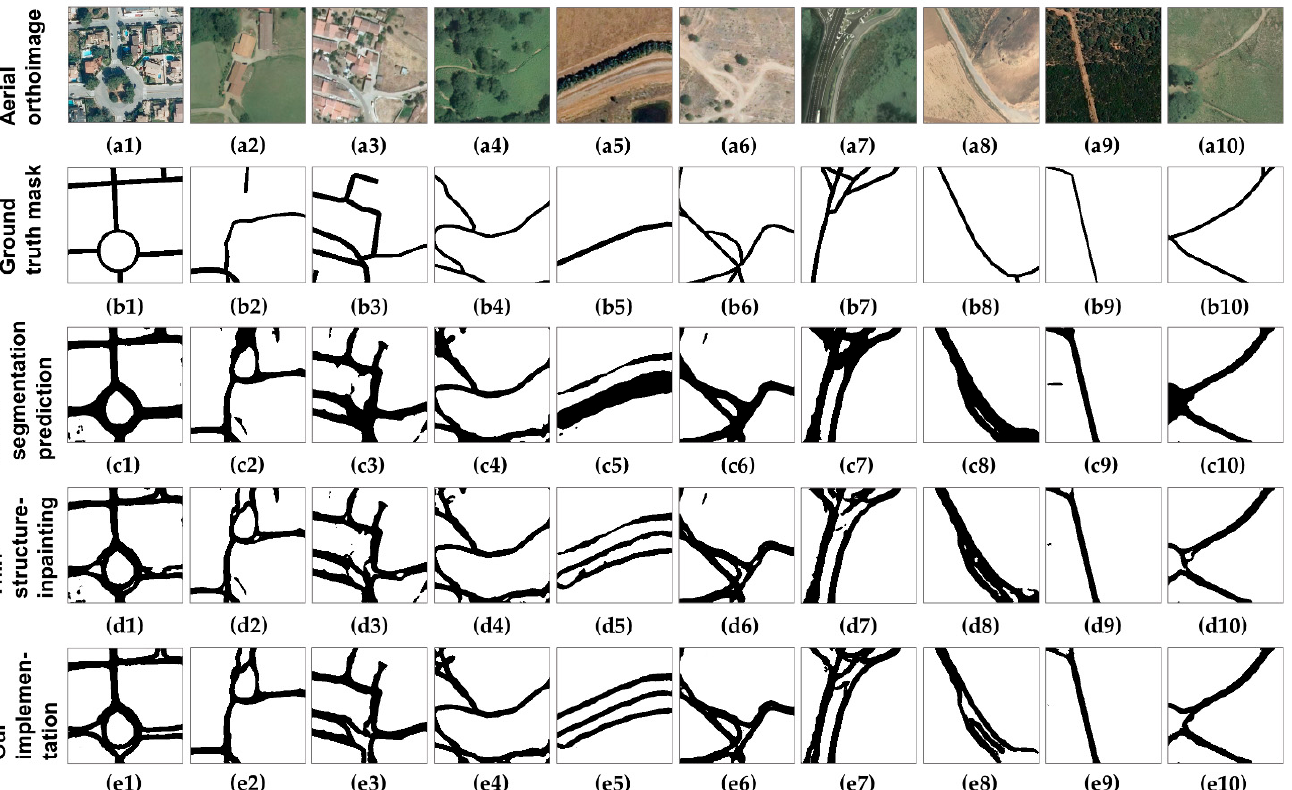
Figure 7. Qualitative interpretation carried out on ten samples from the test set. In the first row ( a1 – a10 ), we have the aerial orthoimage. The second row ( b1 – b10 ) presents the samples from the rasterised ground truth set, or conditional data distribution (road representations present in official cartography). The third row ( c1 – c10 ) shows the initial segmentation prediction obtained using a state-of-the-art semantic segmentation model. The fourth row ( d1 – d10 ) presents the predictions generated with the Thin-Structure-Inpainting model [15] trained for deep inpainting operations, while the fifth row ( e1 – e10 ) presents the reconstructed road masks generated with the conditional generative model proposed in this paper.